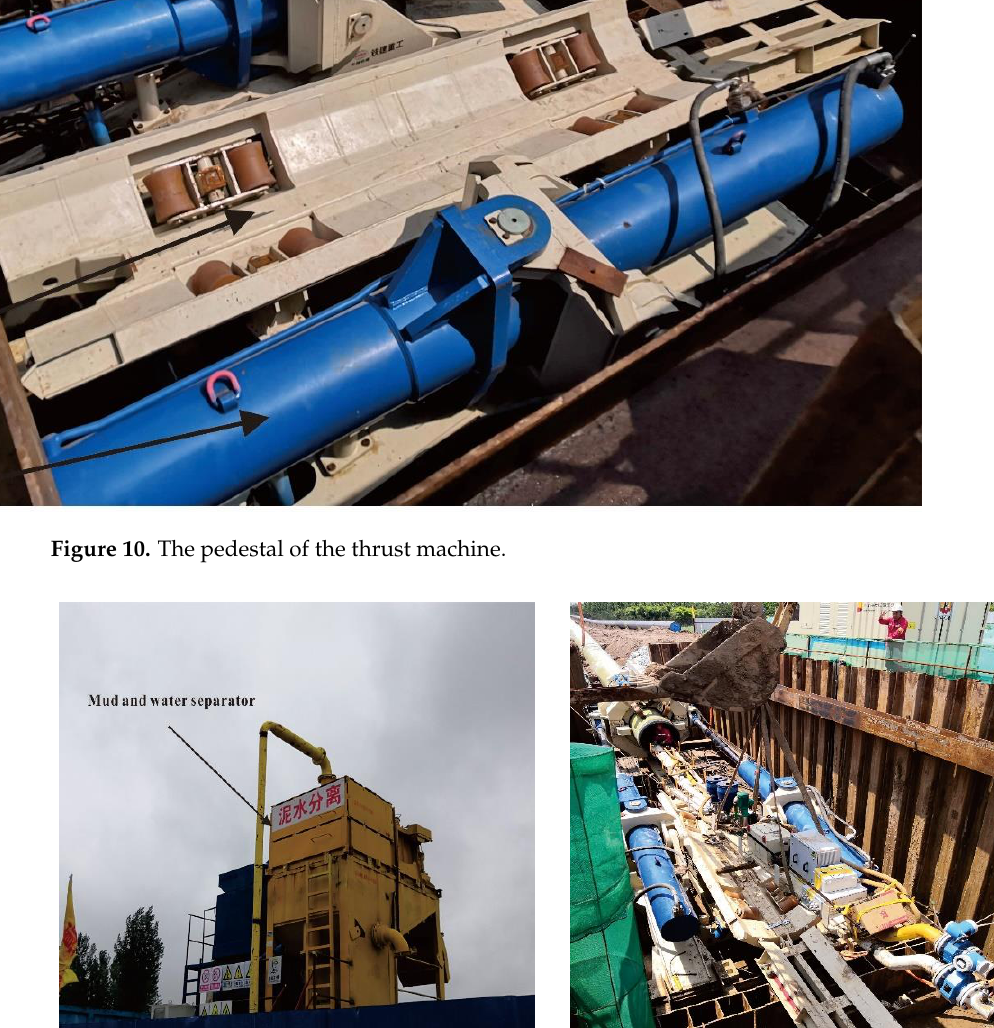
Figure 10. The pedestal of the thrust machine.